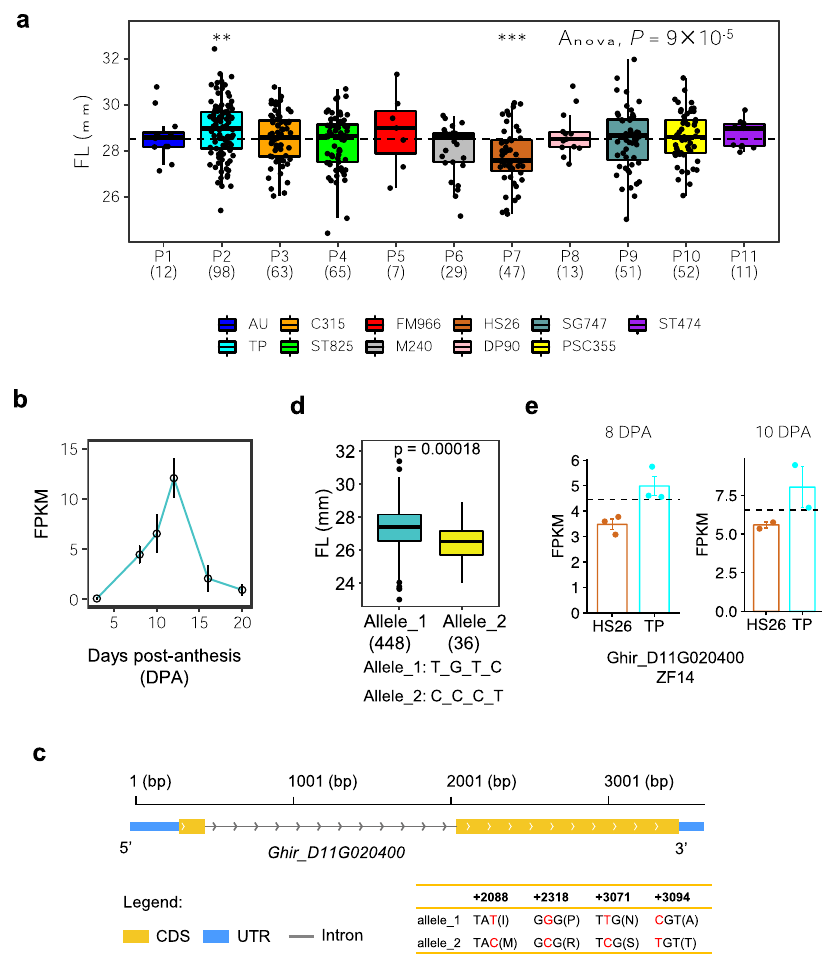
Fig. 5 Inference of functional allelic types across parent IBD groups for FL on chromosome D11 (24.25-24.72 Mb) and identi fi cation of candidate genes. a Boxplots for FL based on the different parent IBD groups ( P ). Parent IBD group was de fi ned by the different status of bin16702 and bin16703. Dashed line indicates the mean of FL in all RILs. ANOVA ( P = 9 × 10 − 5 ) shows that the mean values of different parent IBD groups are not equal. Differences between RILs of a single parent IBD group and all RILs were analyzed by a two-tailed Student ’ s t -test (*** P < 0.001; ** P < 0.01). The numbers in parentheses are the MAGIC RIL counts in each parent IBD group. b Expression level of GhZF14 from 3 to 20 days post-anthesis (DPA) during fi ber development. Error bars represent s.d. c Gene structure of GhZF14. Blue rectangles, yellow rectangles, and black lines indicate UTR, CDS, and intron, respectively. d Box plots for fi ber length with the two functional alleles shown above (n = 448 vs. 36). Center line, median; box limits, upper and lower quartiles; whiskers, 1.5× the interquartile range. e Expression of gene Ghir_D11G020400 in parent HS26 and TP at 8 DPA and 10 DPA of fi ber